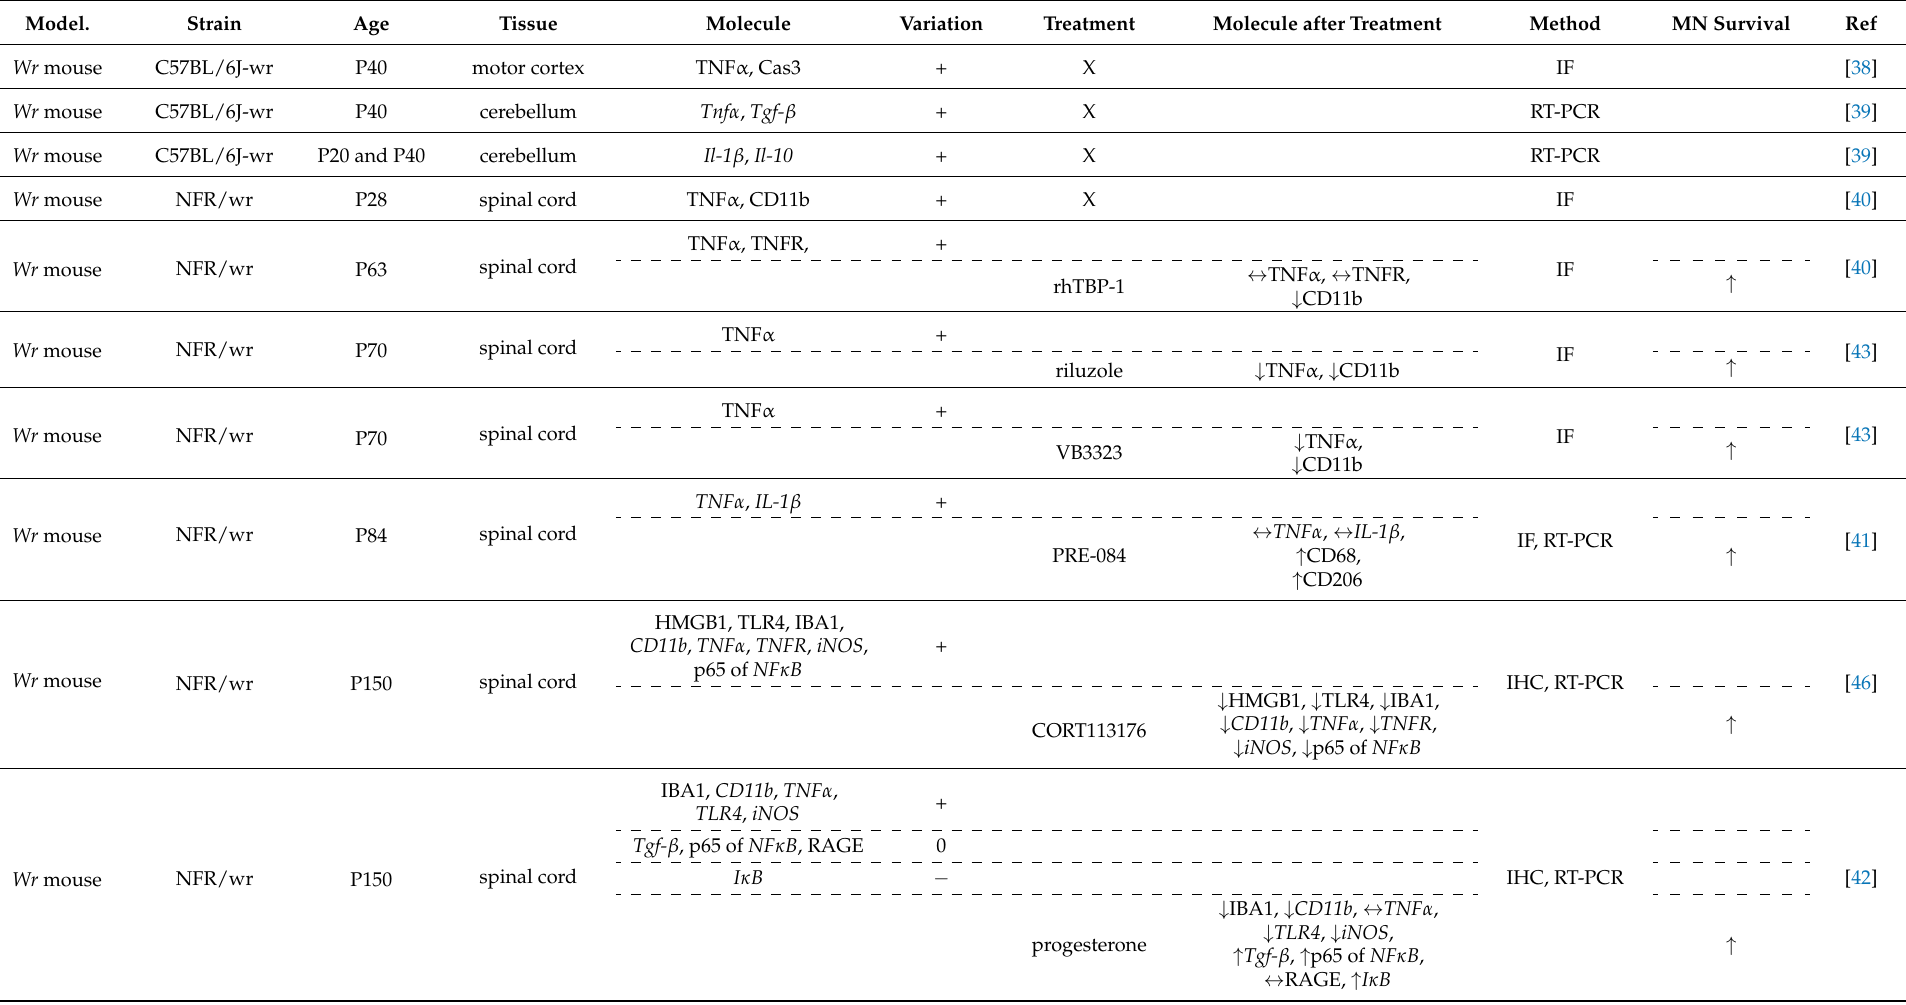
Table 5. Microglial alterations in wobbler mice based on the age, collected tissue and